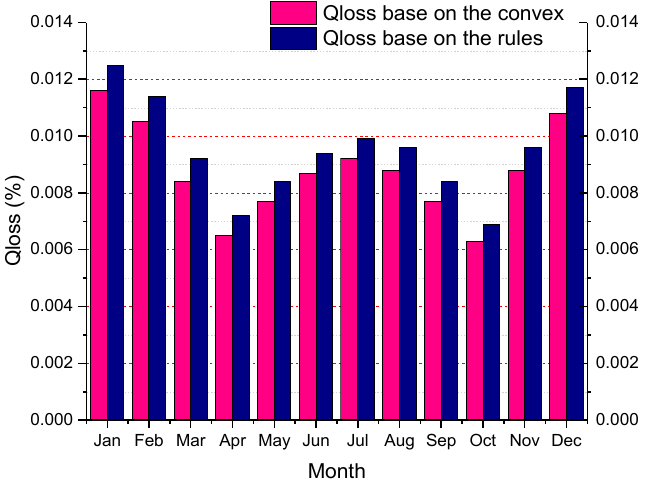
Figure 19. Percentage of battery degradation Q loss in one day for different months.